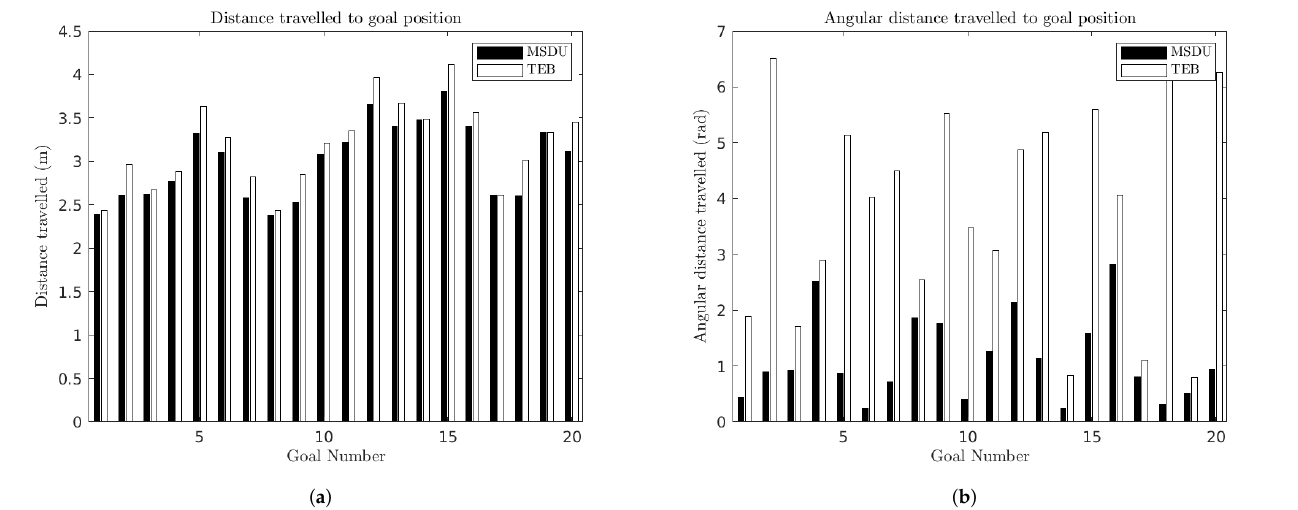
Figure 10. Distance traveled between the starting and final robot pose for the MSDU Local Planner (black) and the TEB Local Planner (white) over long paths. ( a ) Translational distance traveled between the starting and final robot pose ( b ) Angular distance traveled between the starting and final robot pose. Table 4. Summary of distances traveled by MSDU and TEB for long paths. Translational Distance Traveled